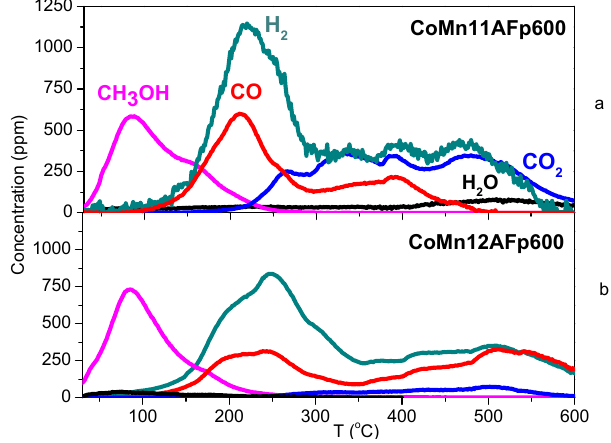
Figure 10. CH 3 OH ‐ TPD on CoMn11AFp600 and CoMn12AFp600.